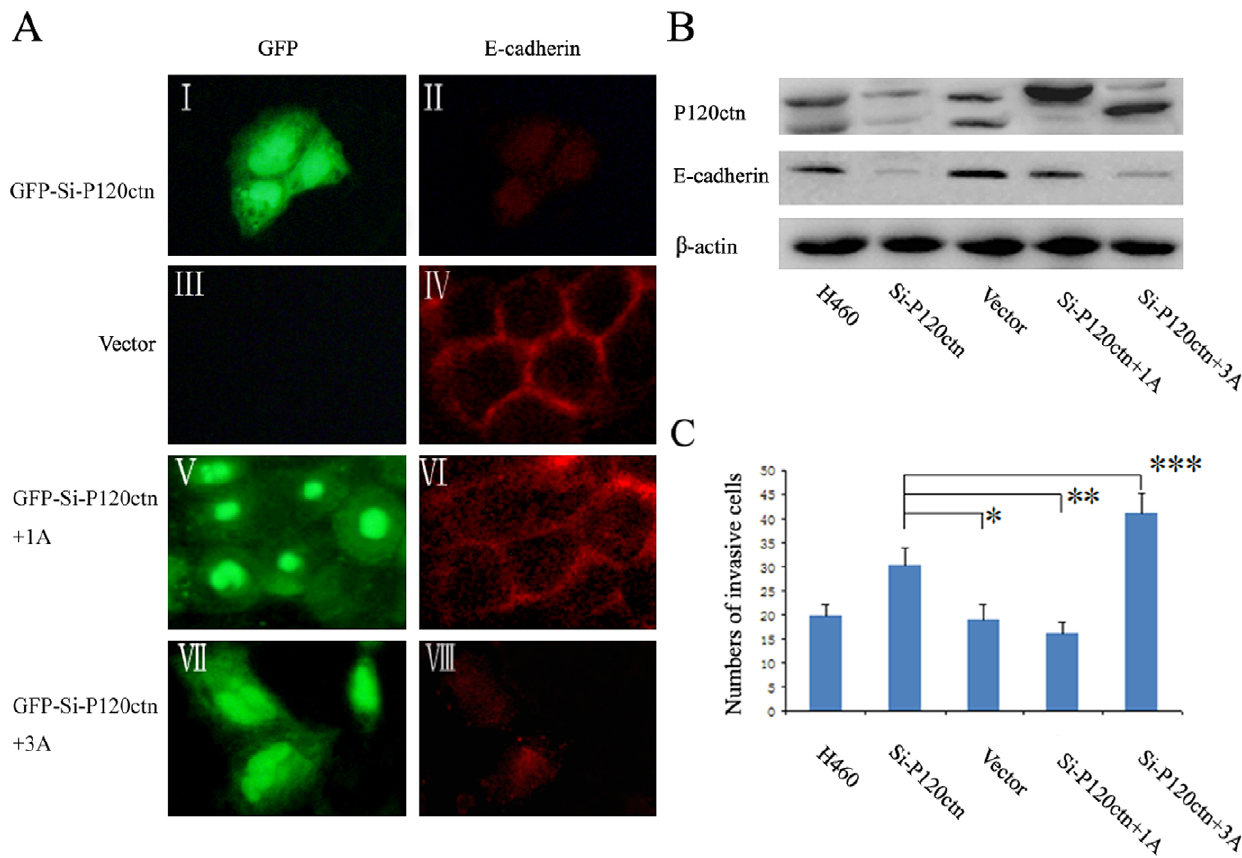
Figure 3. P120ctn isoform 1A restored E-cadherin on the cell membrane and suppressed the invasiveness in H460 cells. H460 cells were transiently transfected with GFP-siRNA-p120ctn plasmids or with empty vector as control. 24 hours after transfection, an aliquot of the cells was transfected again with p120ctn isoform 1A or 3A cDNA plasmids. ( A ) Levels and localization of E-cadherin were analyzed by immunofluorescence. The green signal shown in the nucleus and cytoplasm indicates effective expression of GFP from GFP-siRNA-P120ctn, confirming the successful transfection. Depletion of p120ctn (I) reduced the E-cadherin levels (II). Transfection with empty vector (III) did not affect the E-cadherin levels (IV). Restitution of p120ctn isoform 1A (V) restored the E-cadherin on the cell membrane (VI), while restitution of p120ctn isoform 3A (VII) had no effects on E-cadherin levels (VIII). ( B ) Levels of E-cadherin were then analyzed by Western blot assay. The results confirmed that depletion of p120ctn resulted in decreased E- cadherin levels; restitution of p120ctn isoform 1A restored the E-cadherin levels, while restitution of p120ctn isoform 3A had no effects on E-cadherin expression. ( C ) The invasiveness of H460 cells were analyzed by Matrigel invasion assay. P120ctn ablation enhanced the invasiveness in comparison with the control group transfected with vectoralone (*, P , 0.01). Restitution of p120ctn isoform 1A reducedtheinvasiveness of H460 cells in comparison with the group with p120ctn ablation (Si-p120ctn) (**, P , 0.01), while p120ctn isoform 3A increased the invasiveness (***, P , 0.01).